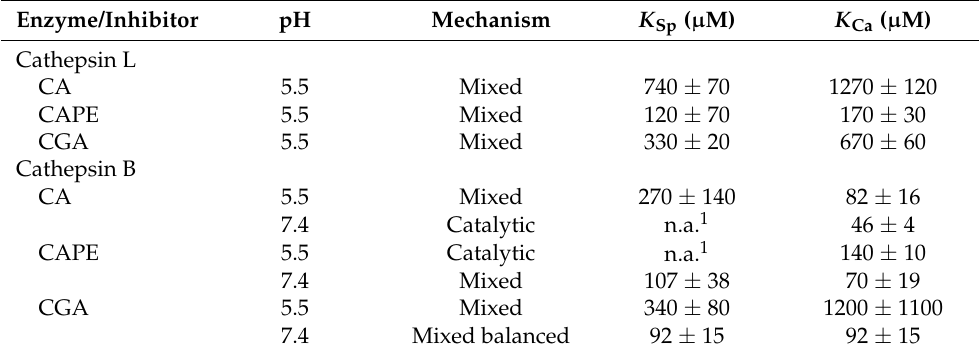
Table 2. Kinetic parameters for the inhibition of cathepsins B and L by caffeic acid (CA), caffeic acid phenethyl ester (CAPE), and chlorogenic acid (CGA). Parameters were determined by non-linear regression analysis of titration curves recorded at three different substrate concentrations using Equations (2) and (3).